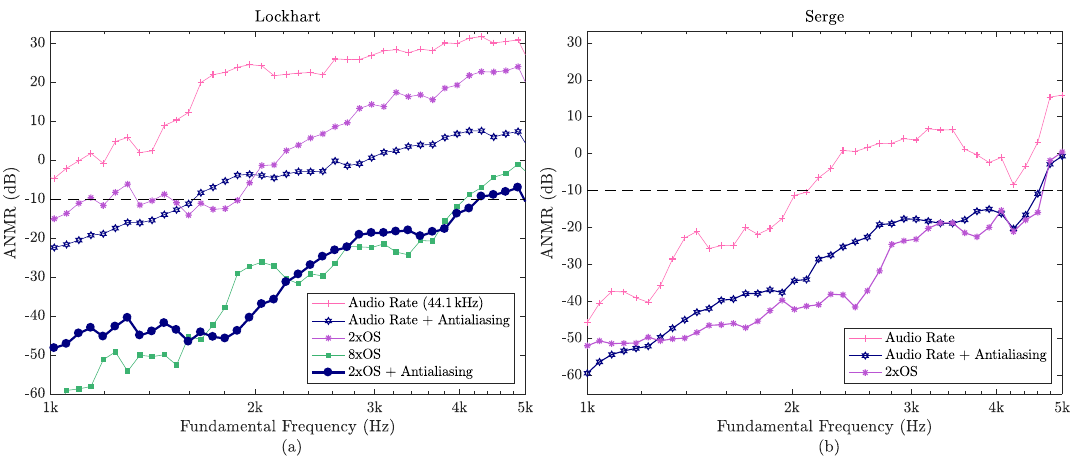
Figure 15. Measured A-weighted noise-to-mask ratios (ANMRs) for a range of sinusoidal waveforms processed: ( a ) using the Lockhart wavefolder model ( R L = 50k Ω ) under six different sampling rates; and ( b ) using the Serge wavefolder model under two different sampling rates, with and without the proposed antialiasing method. Values below the − 10 dB threshold indicate lack of perceivable